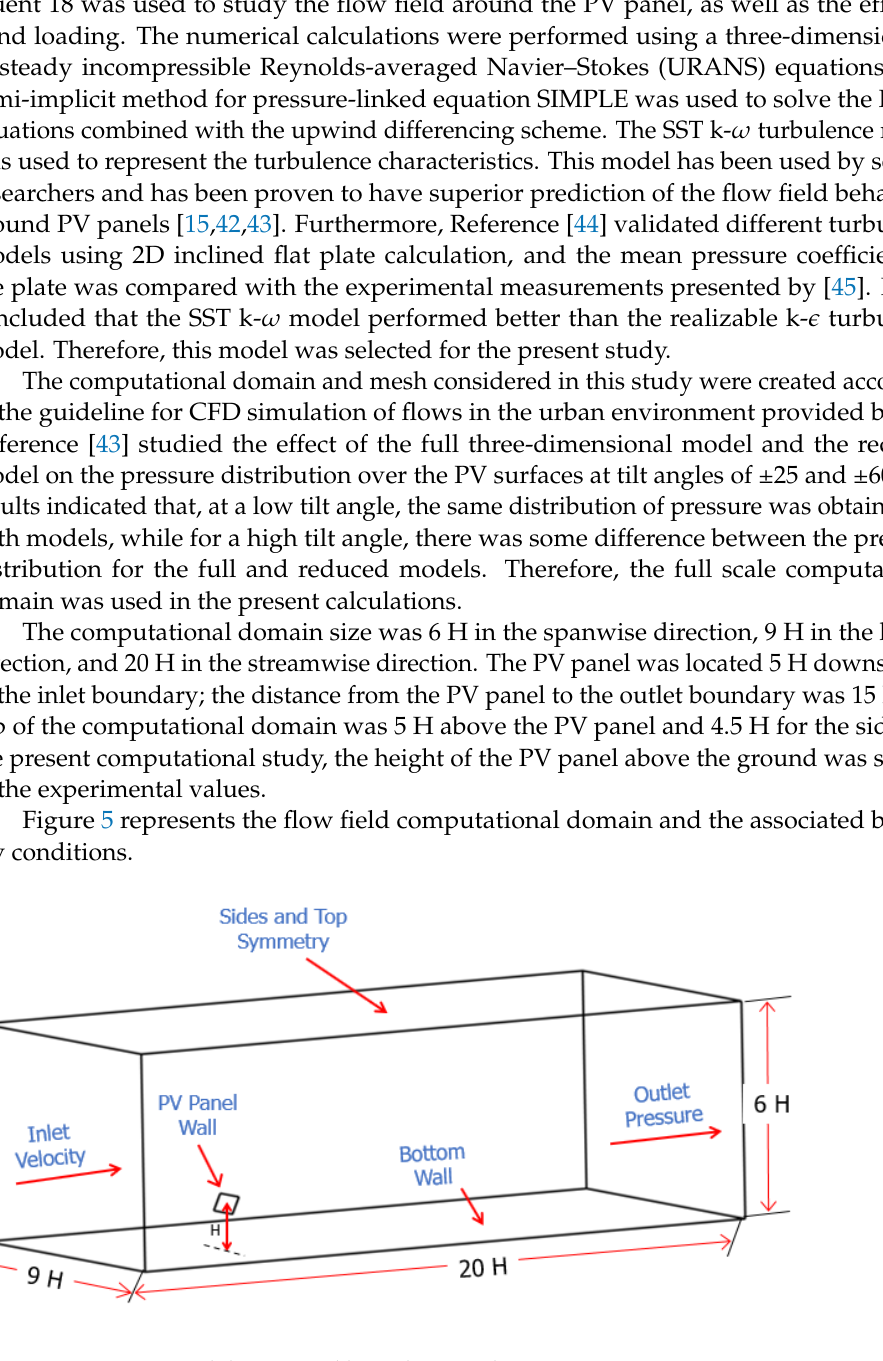
Figure 5. Computational domain and boundary